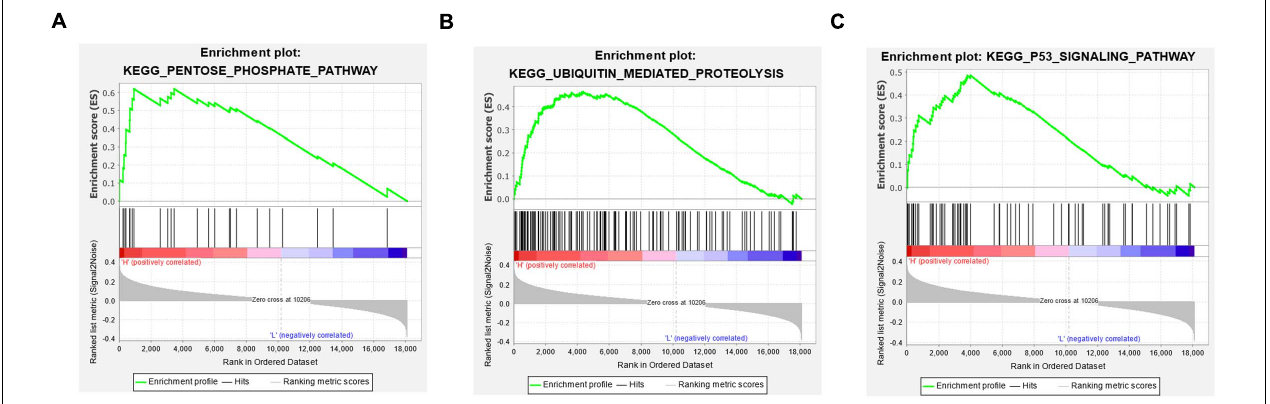
FIGURE 8 | GSEA enrichment analysis in the high- and low-risk groups. (A–C) Patients in the high- and low-risk groups showed marked differences in pentose phosphate pathway, ubiquitin mediated proteolysis, and P53 signaling pathway signaling pathways,